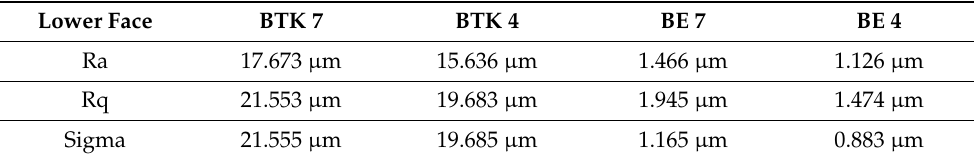
Table 1. Roughness parameters on lower faces of both samples. The numbers of samples used for the analysis are identified in each